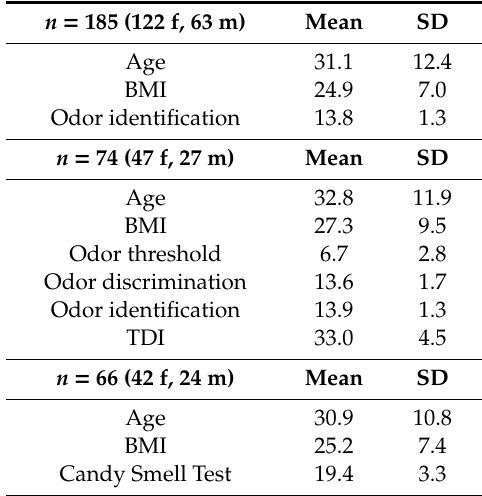
Table 4. Subject characteristics and obtained olfactory scores.